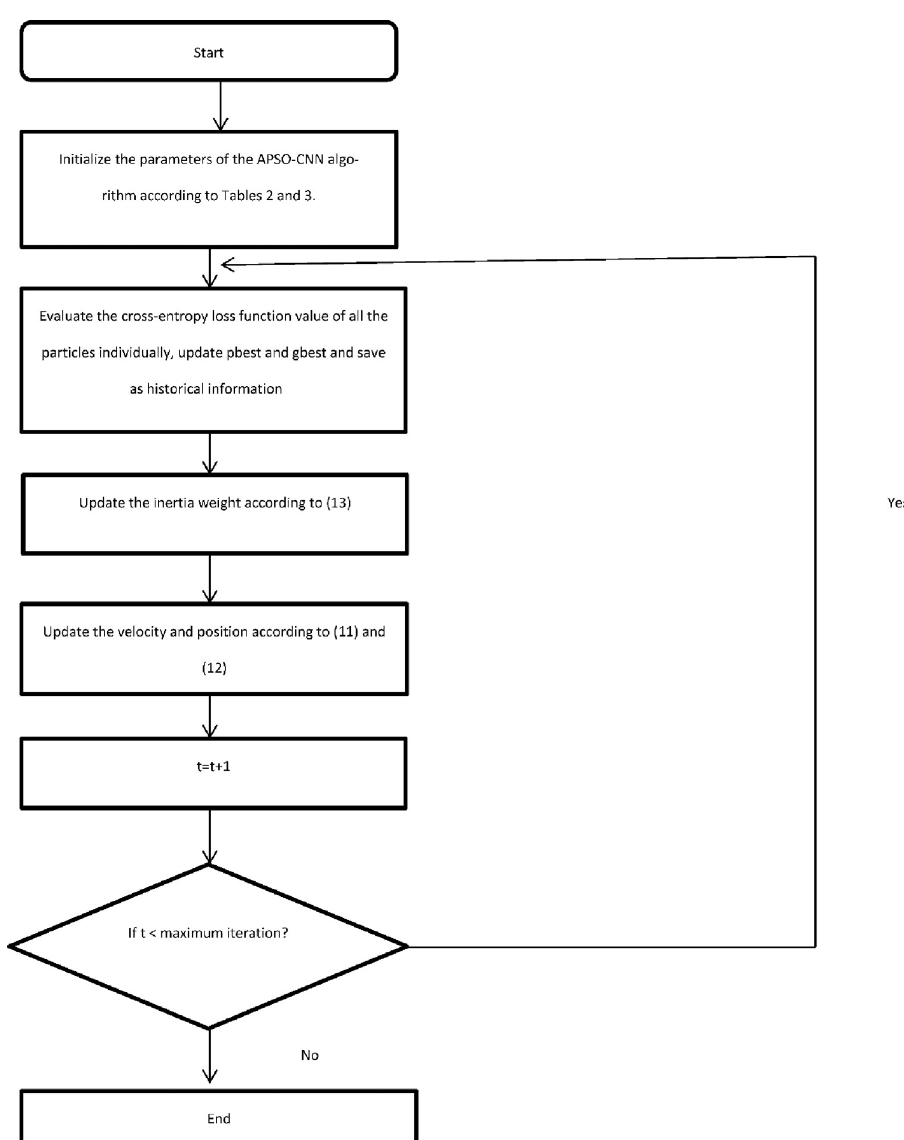
Fig 2. The APSO-CNN algorithm